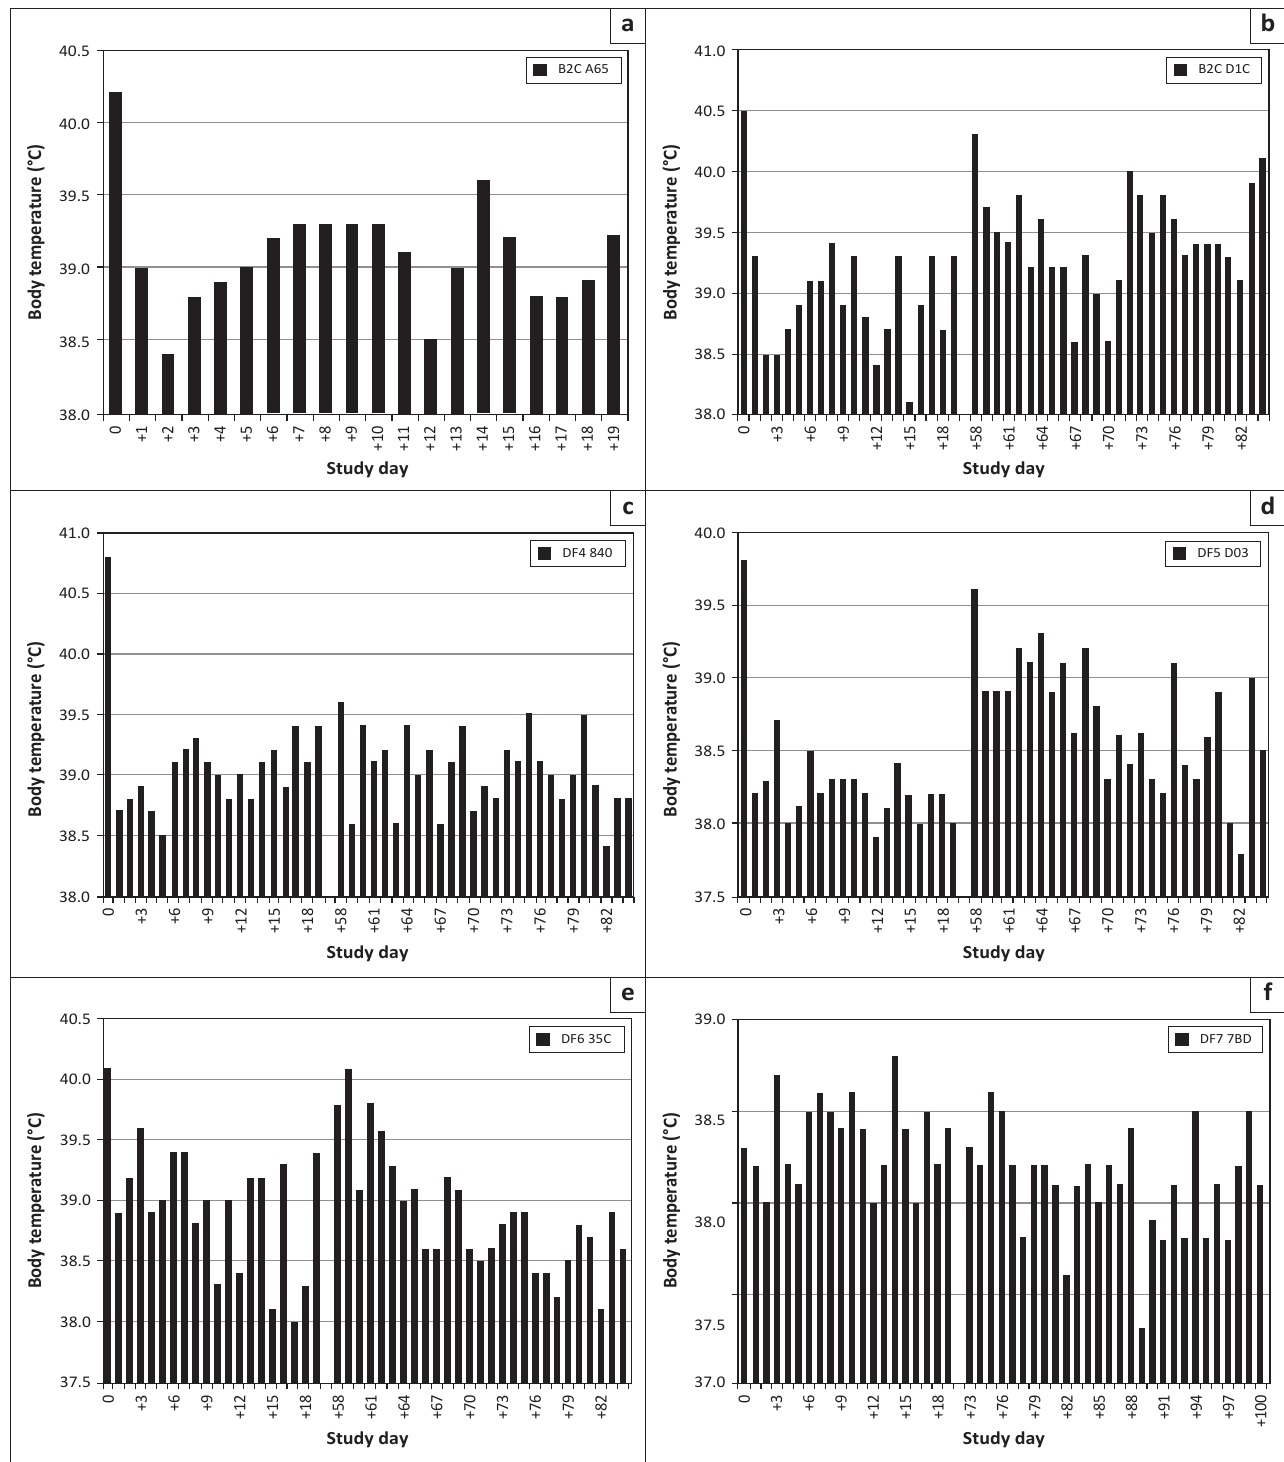
FIGURE 1: Body temperatures measured for the respective dogs (a–f), on the study days indicated (temperature equal to or exceeding 39.5